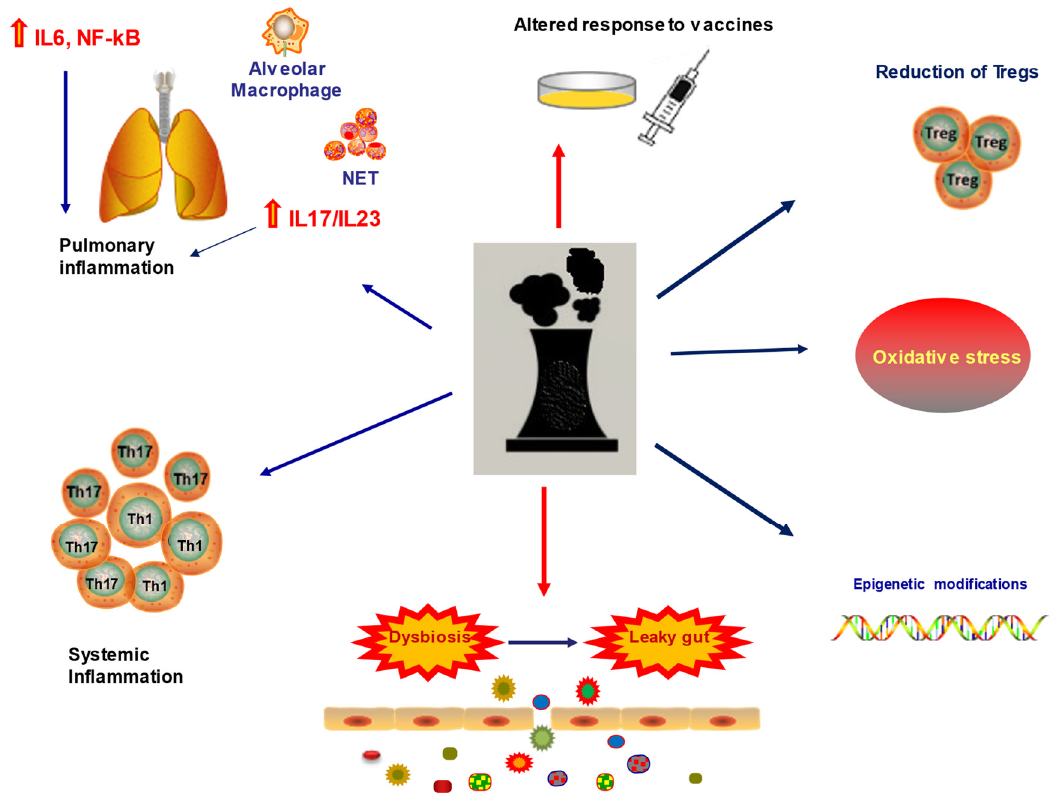
Figure 1. Impact of pollution on human health. Pollution impacts human health on many levels: on the immune system, enhancing pulmonary, intestinal, and systemic inflammation. Pollution can increase the risk of developing cancer through epigenetic modifications and oxidative stress. Pollutants can directly affect the response to vaccines. Abbreviations: NET: neutrophils extracellular traps, IL: interleukin; Tregs: T regulatory cells.